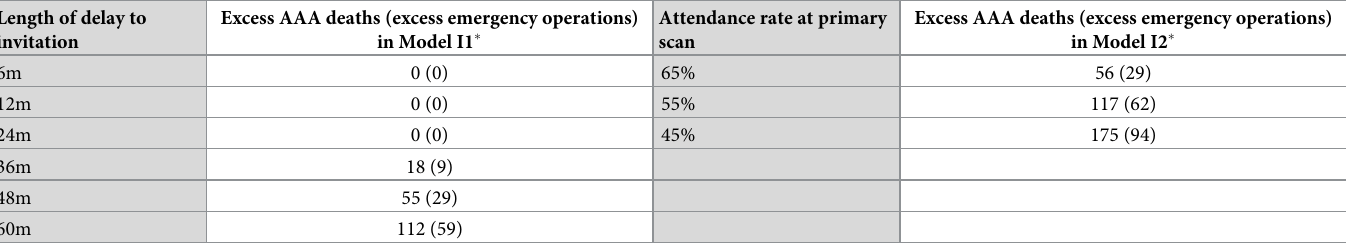
Table 2. Predicted excess AAA deaths and emergency operations in the national invited 65-year-old cohort over 30y period. Length of delay to invitation